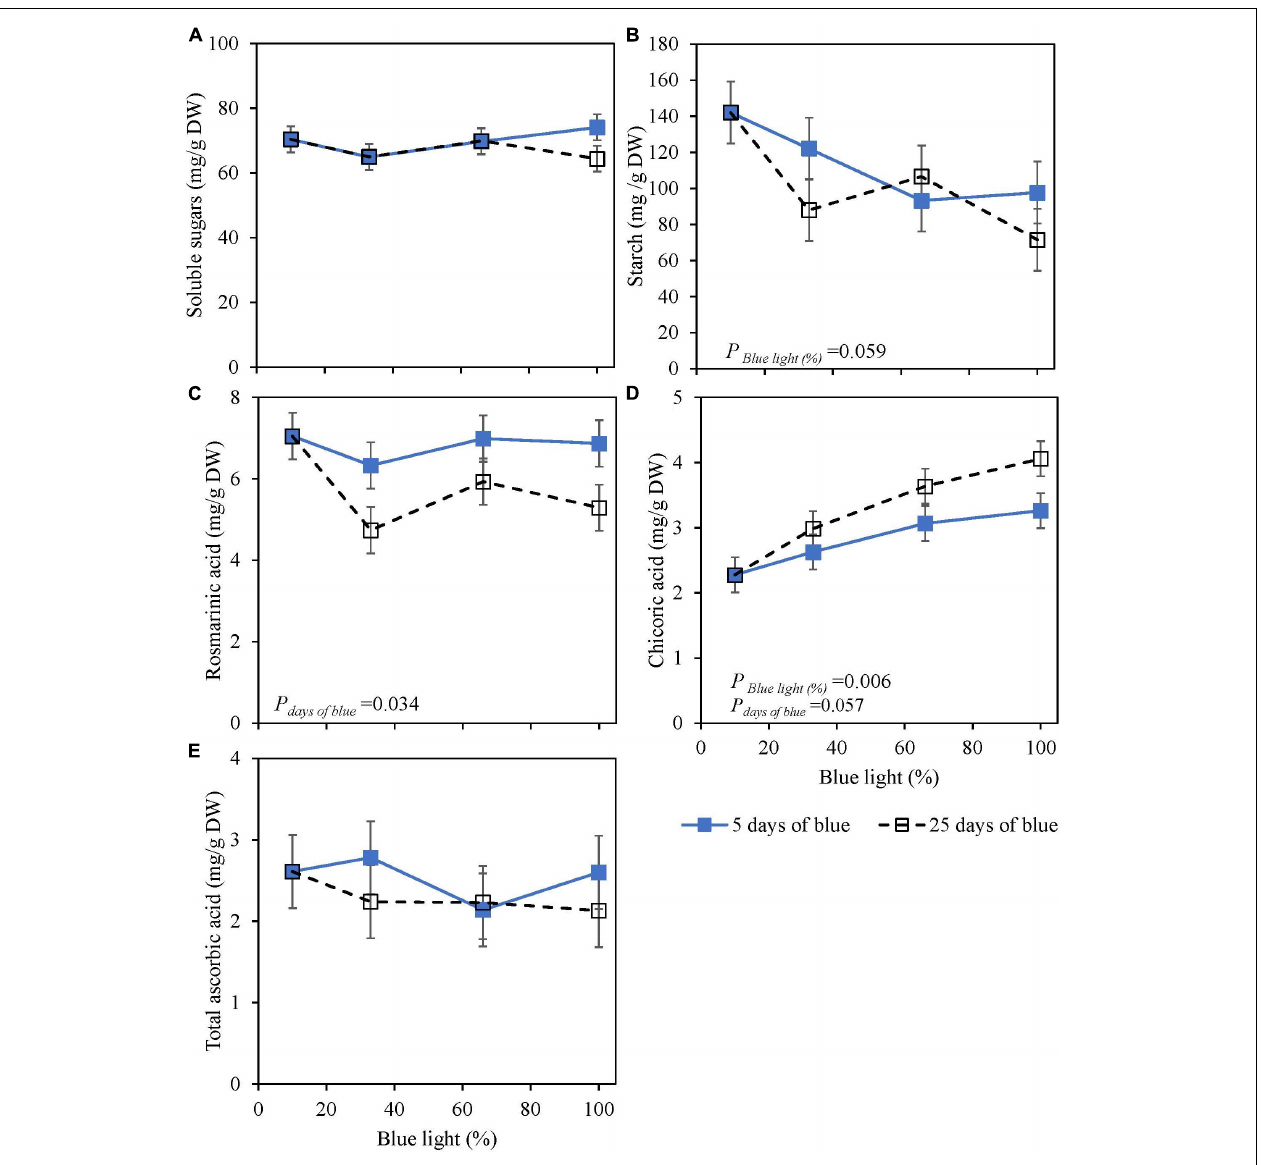
FIGURE 1 | Metabolite levels at harvest in basil cv. Dolly exposed either continuously (25 days) (open symbols) or for 5 days of End-Of-Production (EOP) (closed symbols) to different percentages of blue light. Plants were harvested after 40 days of cultivation. After 15 days, plants were transplanted. After the transplant, the continuously treated plants grew under different percentages of blue light until harvest [photon flux density (PPFD) of 300 µ mol m − 2 s − 1 ]. The EOP plants were grown under red-white (PPFD of 300 µ mol m − 2 s − 1 , 9% blue) light and later exposed to different percentages of blue light (PPFD of 300 µ mol m − 2 s − 1 ) for the last 5 days before harvest as EOP treatments. (A) Soluble sugars (sum of glucose, fructose, and sucrose), (B) starch, (C) rosmarinic acid, (D) chicoric acid, (E) total ascorbic acid. All values are expressed per gram dry weight in the leaves. The data are means of two blocks ( n = 2) (i.e., per block four replicate plants). Standard errors of means are shown as error bars. Significance of the main effects percentage of blue and days of blue ( α = 10%) are depicted (Experiment